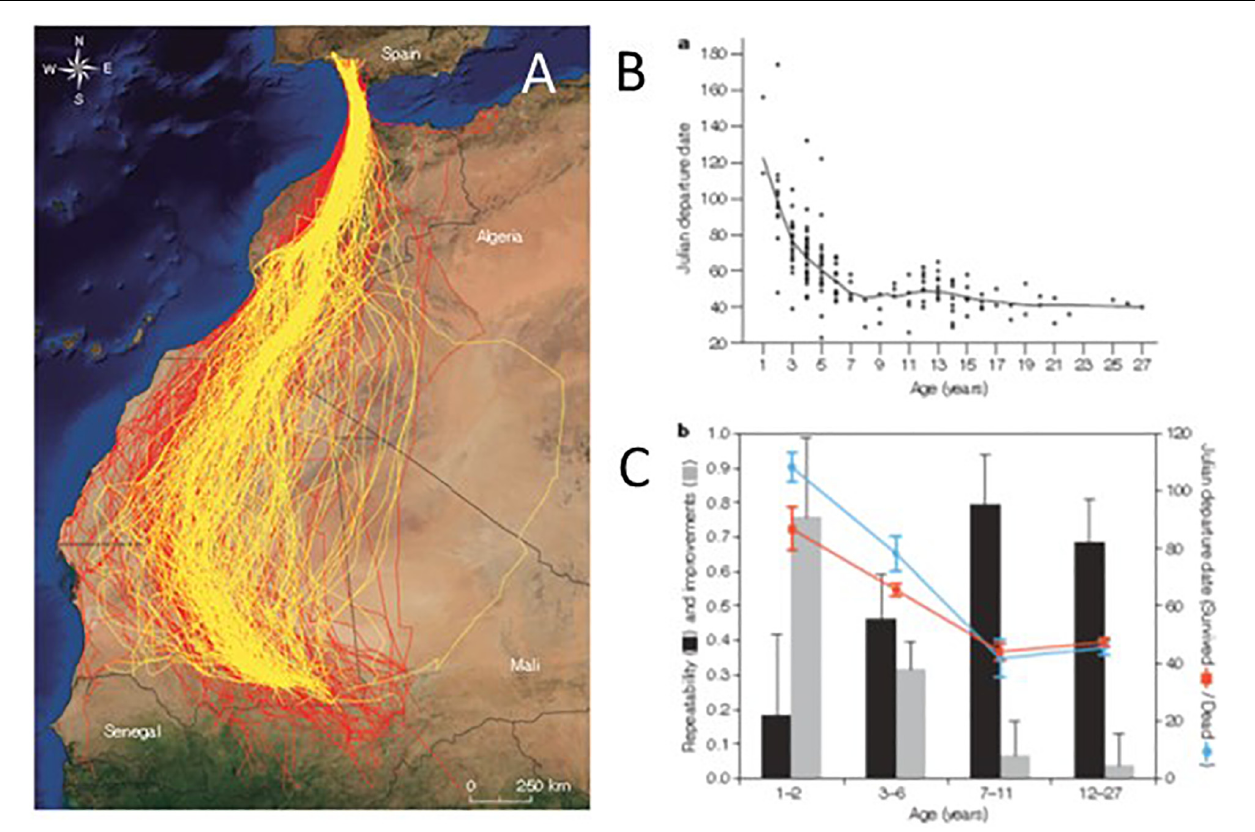
FIGURE 7 | Migration performance and route choices across time for migratory Black Kites tracked for 1–27 years. (A) Migration routes of individually tracked Black Kites from breeding sites in southwestern Spain to wintering areas in West Africa. Pre-breeding tracks are shown in red and post-breeding tracks in yellow. (B) Pre-breeding migration departure date in relation to Julian date advanced with age. (C) Migration performance across and within individuals, illustrating that pre-breeding departure date improved rapidly during the first 7 years of life and then reached a plateau. In the initial years birds that survived within the next year (red) departed earlier (right axis) than those that died (blue). Similarly, within individuals, the repeatability of departure (black bars, left axis) was lowest in the initial years of life, when individual improvements (gray bars, left axis) were highest, and stabilized after birds were 7 years old. The cross-sectional pattern depicted in (B) was concluded by Sergio et al. (2014) to be consistent with both within-individual improvements and selective removal of inferior performers. Figures from Sergio et al. (2014), reprinted by permission from Springer, Nature